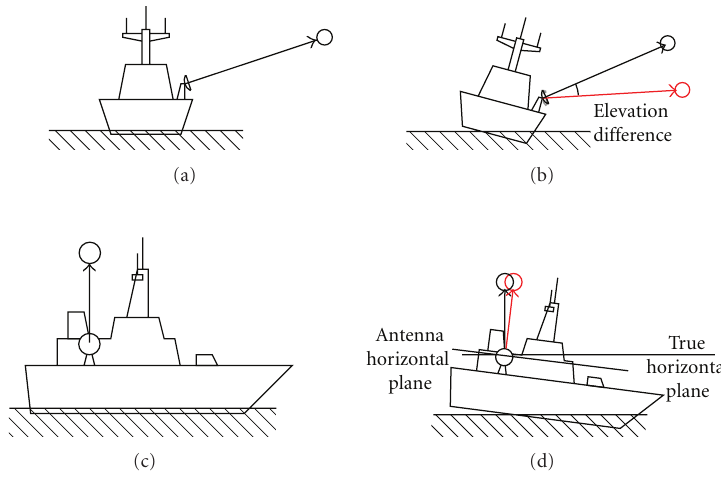
Figure 13: Roll and pitch e ff ects: variation in target elevation (a, b); rotation of the antenna horizontal reference plane (c, d).